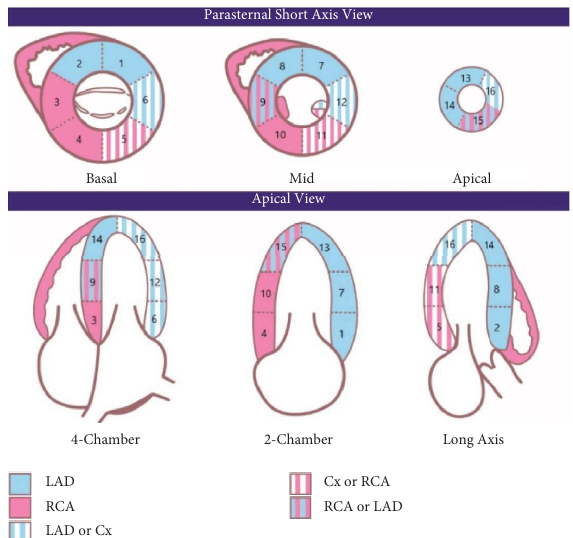
Figure 1: Wall motion scoring segmental analysis by transthoracic echocardiography. LV segments: 1 � basal anterior; 2 � basal an- terior septum; 3 � basal inferior septum; 4 � basal inferior; 5 � basal inferolateral; 6 � basal anterolateral; 7 � mid anterior; 8 � mid an- terior septum; 9 � mid inferior septum; 10 � mid inferior; 11 � mid inferolateral; 12 � mid anterolateral; 13 � anterior apex (ante- roapical); 14 � septal apex (apicoseptal); 15 � inferior apex